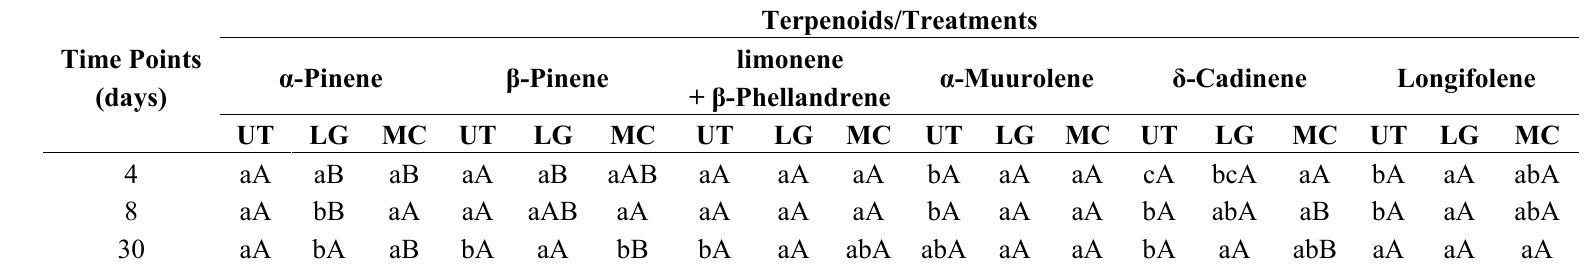
Table 3. Tukey’s tests showed significant differences across comparisons of individual monoterpenes and sesquiterpenes in the phloem of the stem among treatments at each time point and at different time points in individual